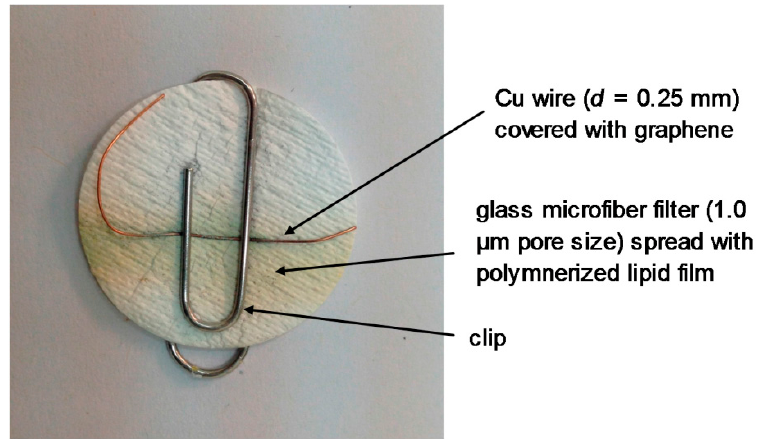
Figure 6. Photograph of the lipid film sensor incorporated on graphene for the potentiometric detection of urea (reprinted from Reference [20]).